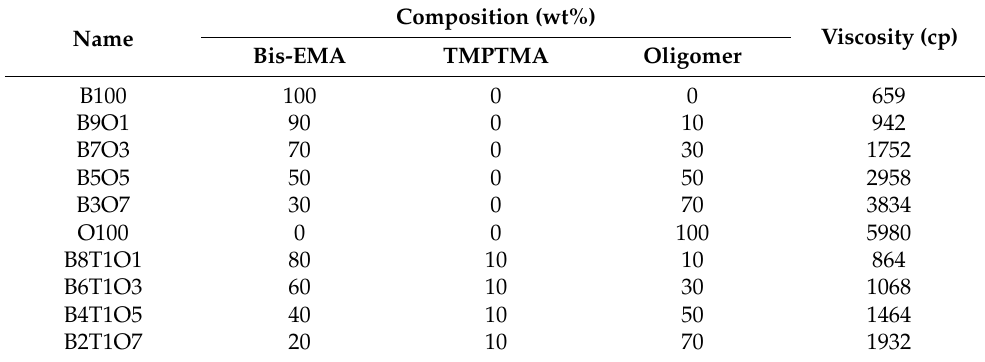
Table 1. Urethane-acrylate resin material contents used